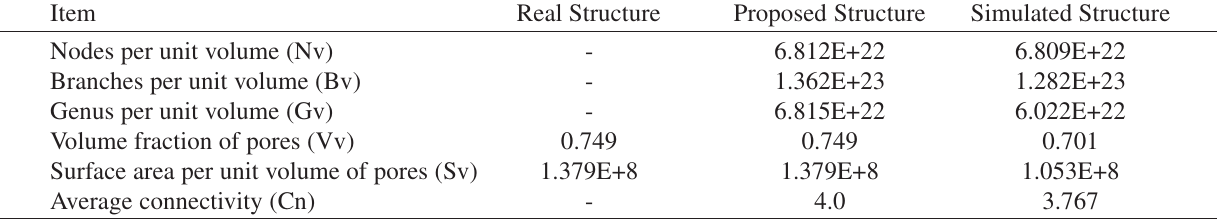
Figure 4. Examples of situations not allowed by the program: a) intersection between a branch and an intermediate node; b) inter- section between two branches. Table 1. Comparisson between the real data, data from the proposed structure and, data from the simulated structure. All the items were calculated considering a cubic meter.